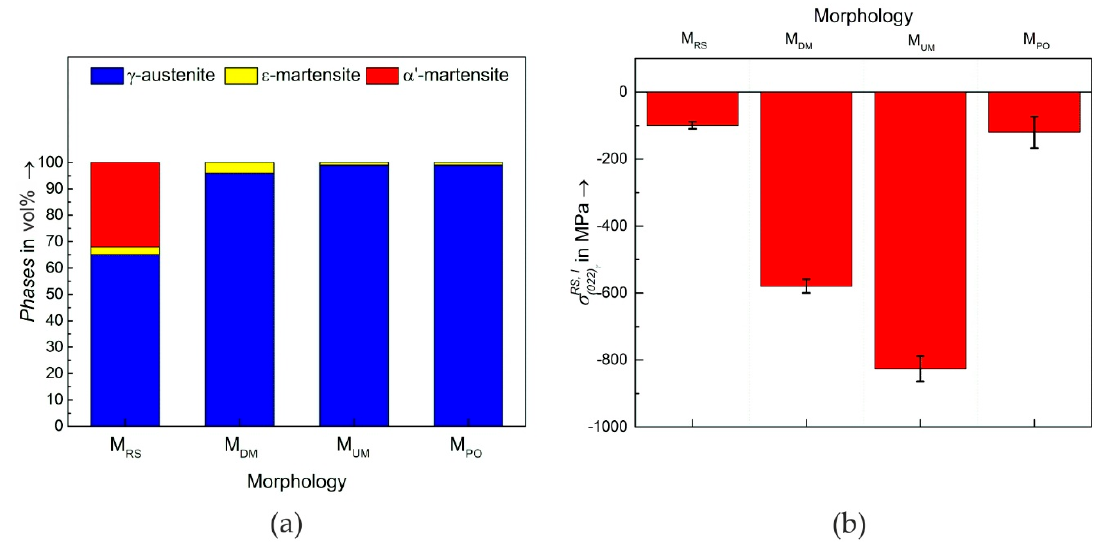
Figure 6. Phase fractions ( a ) and residual stresses ( b ) of investigated surface morphologies.